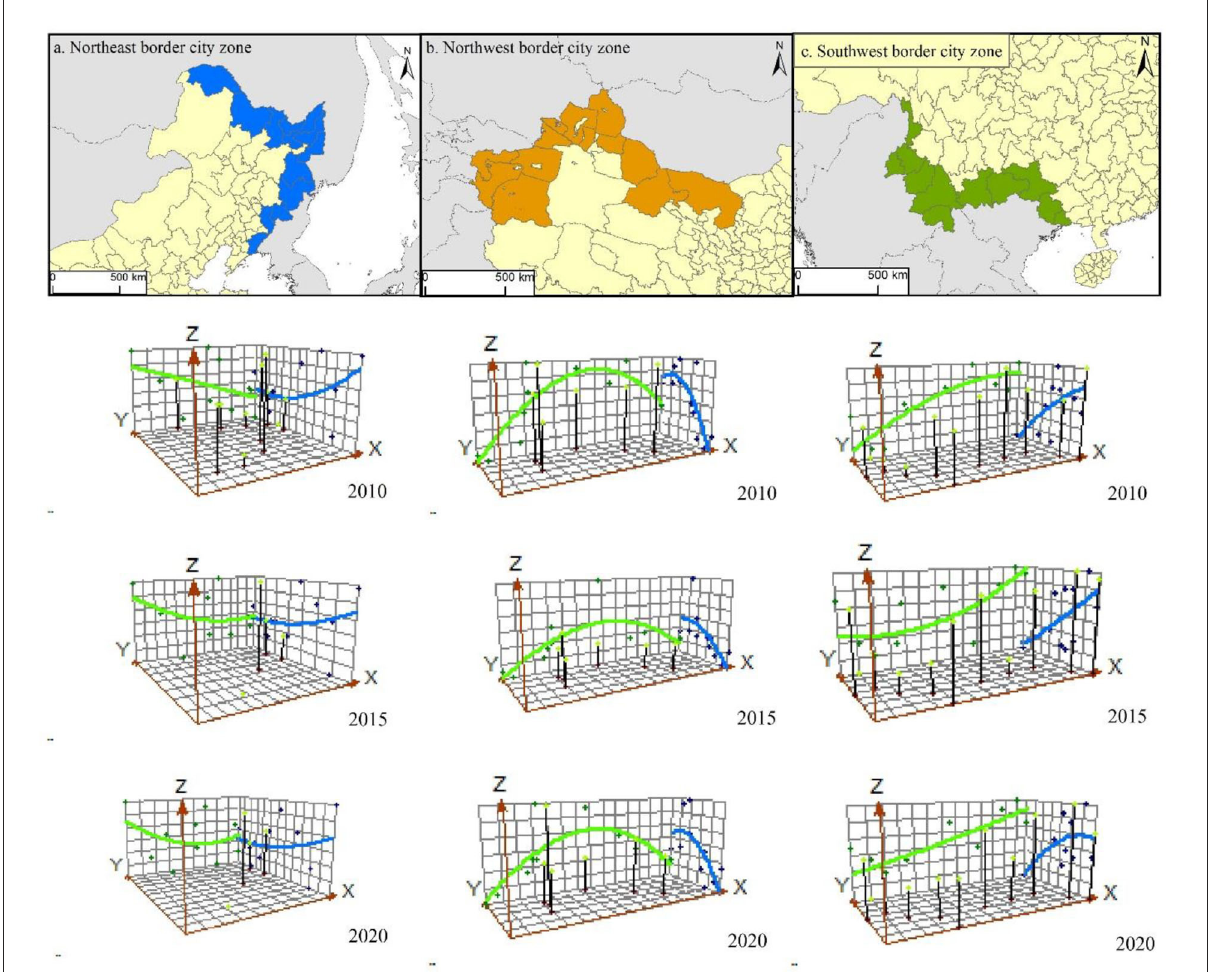
FIGURE3 Trend lines showing the resilience level of China’s border cities in three sample zones in 2010 (a) , 2015 (b) and 2020 (c)